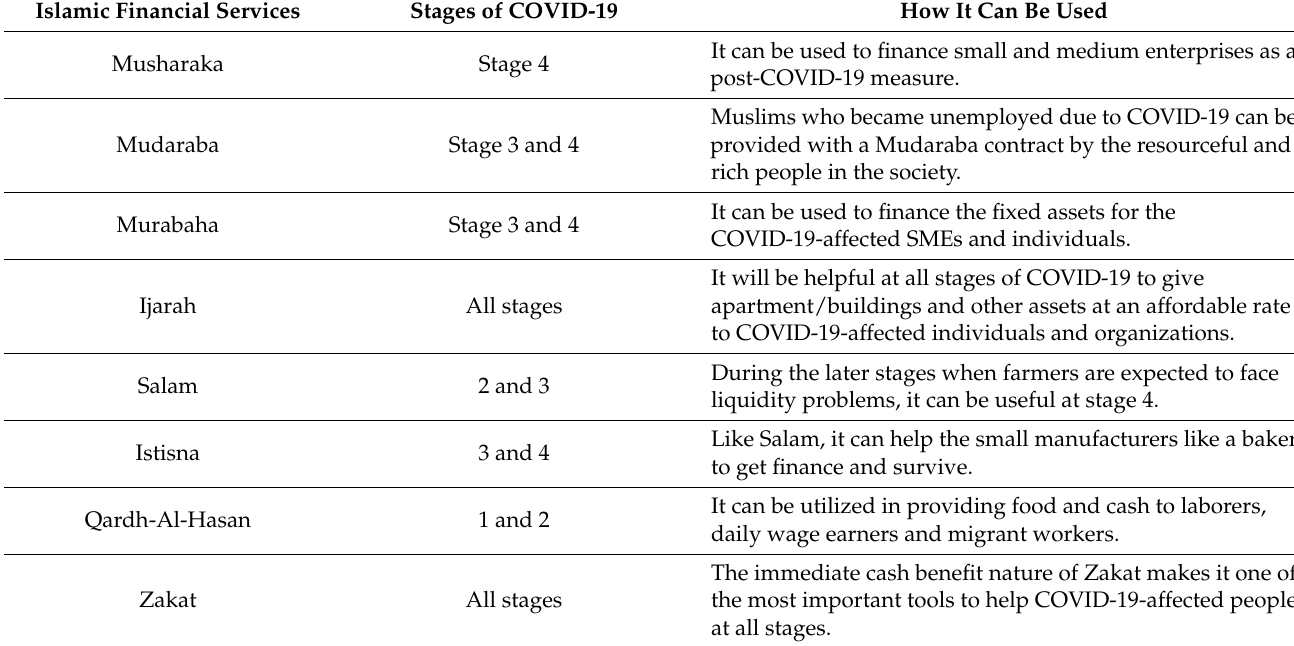
Table 2. Islamic Financial Services at each stage of